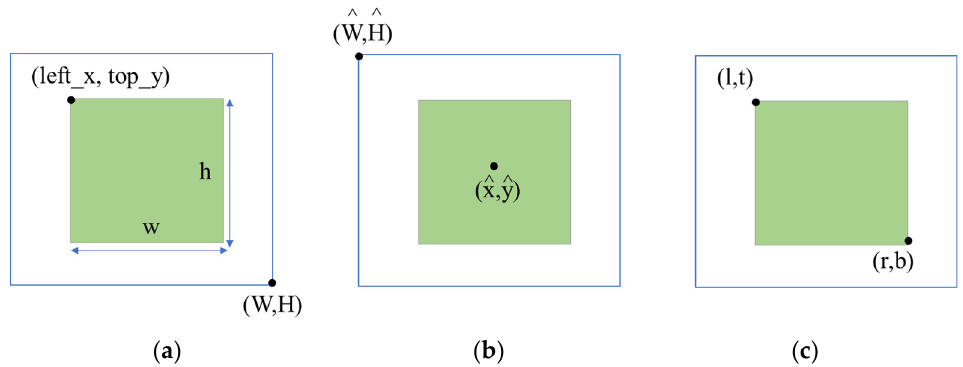
Figure 9. Conversion from Detection Output to YOLO Form. ( a ) YOLOv4 Detection Result; ( b ) Pseudolabeling Result; ( c ) Input Result for YOLOv4.